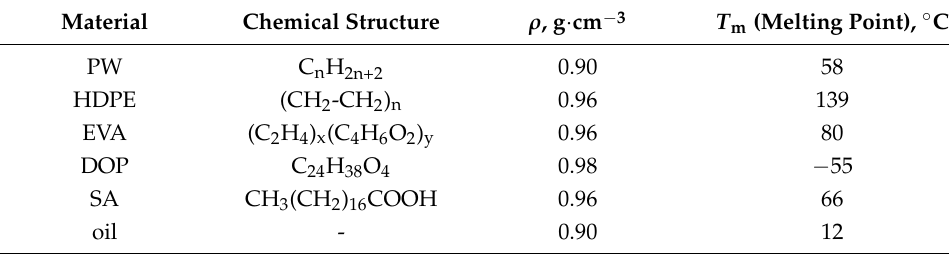
Table 1. Characteristics of each binder component.